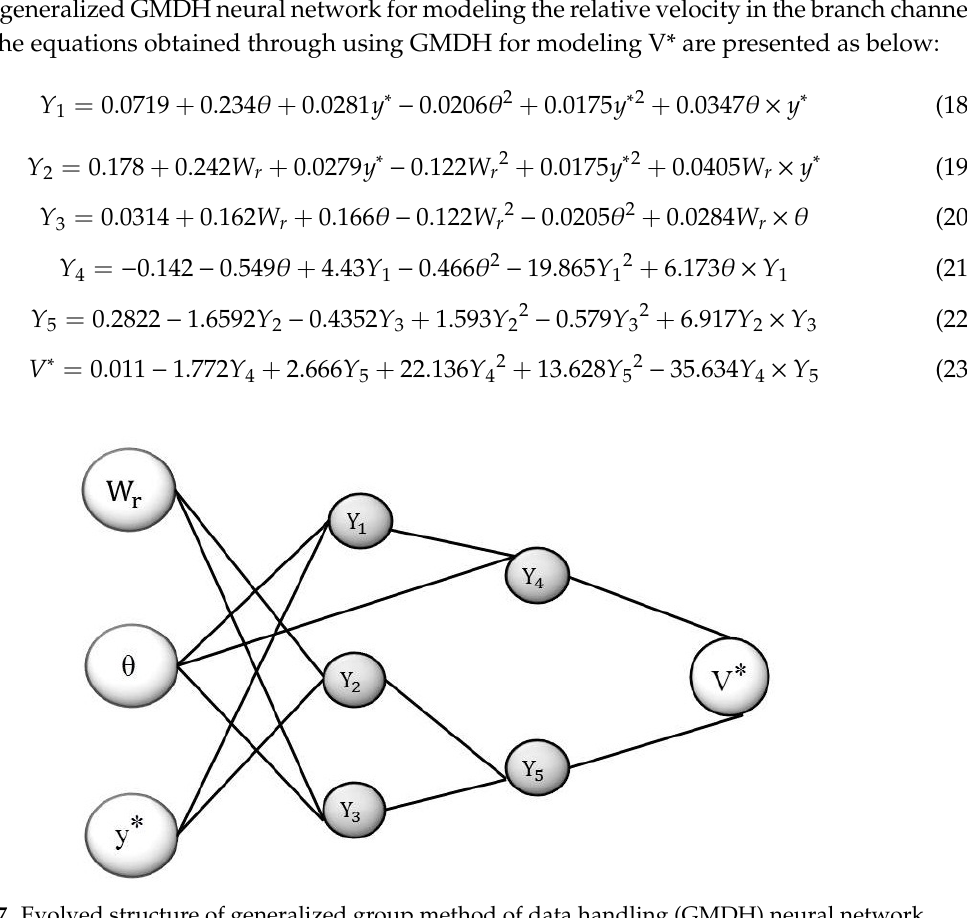
Figure 7. Evolved structure of generalized group method of data handling (GMDH) neural network for modeling and prediction of mean velocity.